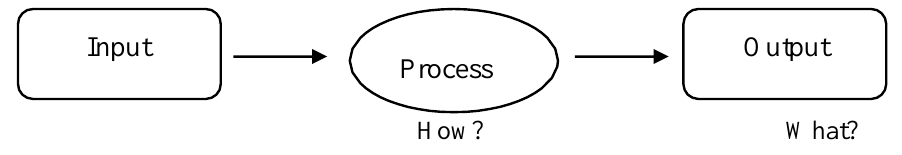
Figure 1. Production System Schematic